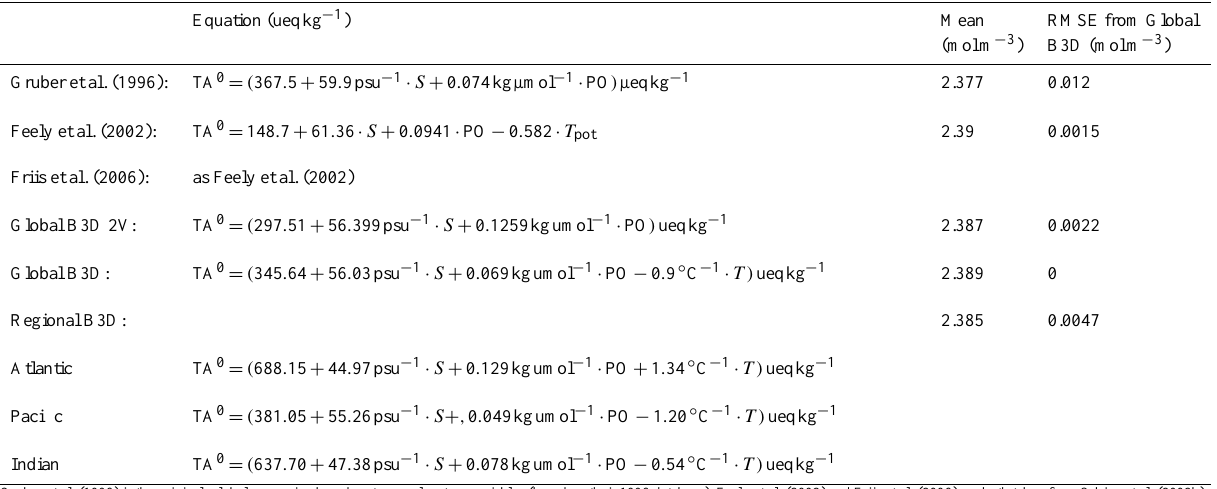
Table 1. Overview of suggested ways of regression for TA 0 either including two ( S , PO) or three ( S , PO, T ) explanatory variables and either as a global or basin-wide fit. The last column shows the root mean square error relative to the Global B3D estimate. Equation (ueqkg − 1